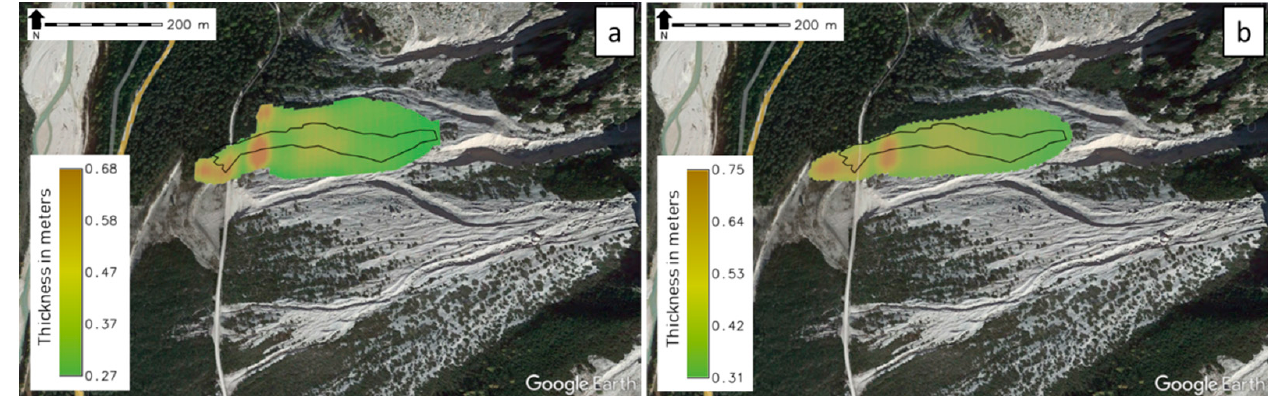
Figure 4. GPUFLOW simulations of the 2006 debris flow in the Dolomites without ( a ) and with ( b ) the bias correction. Colors represent the deposit thickness in meters. The actual debris field was redrawn from [44].